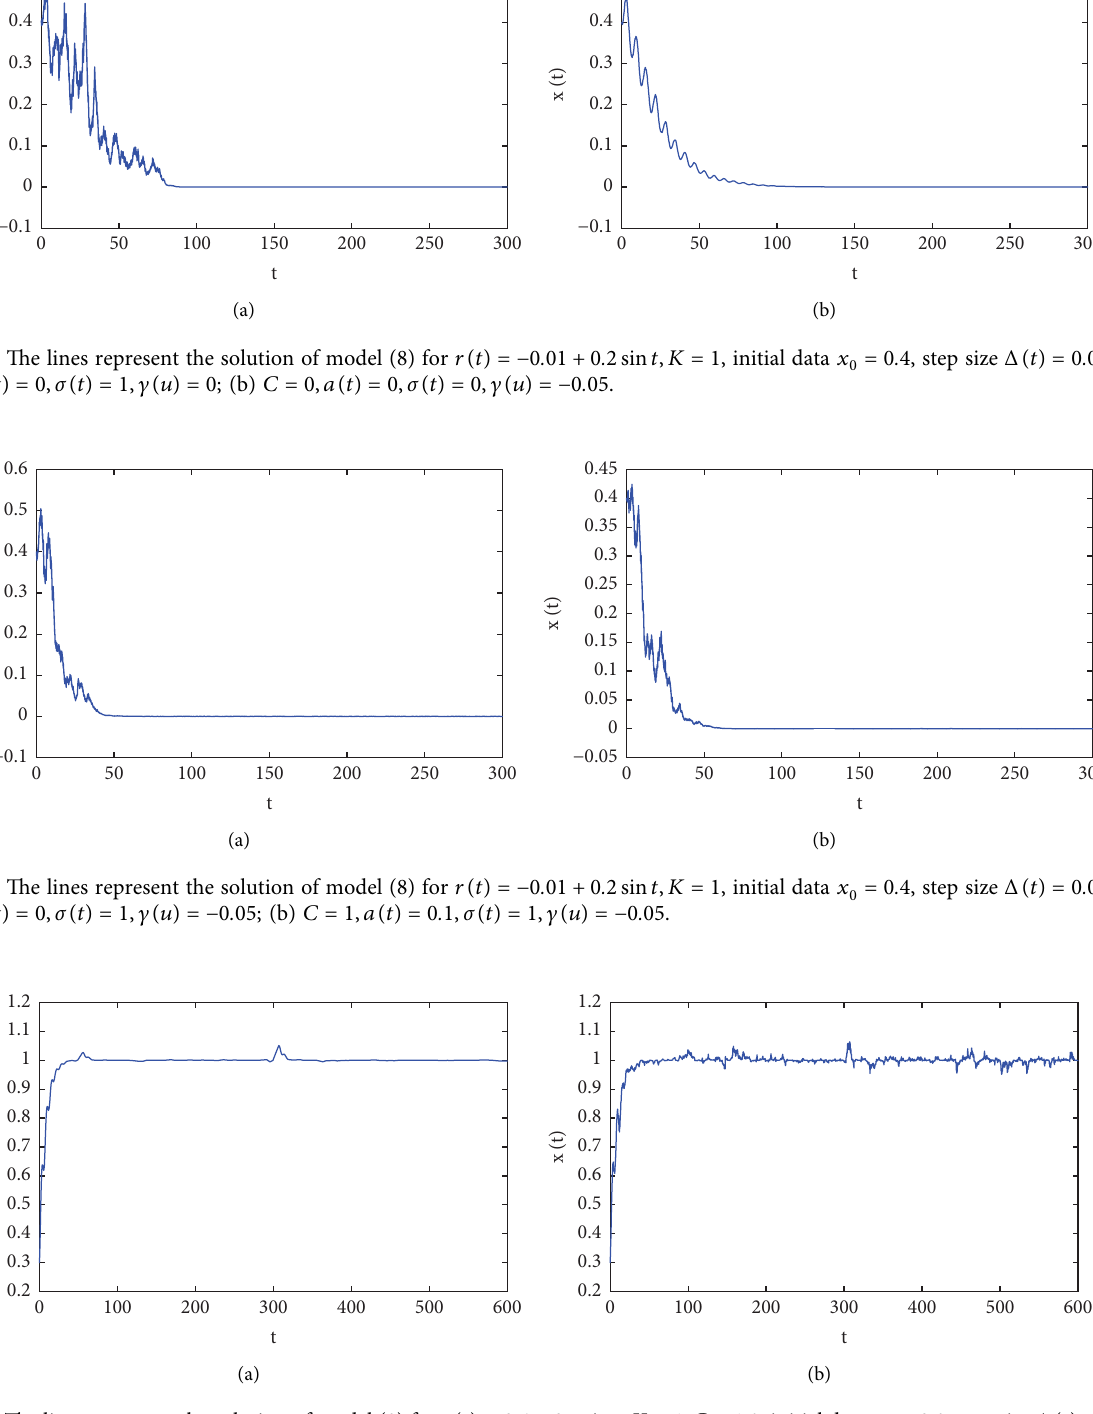
� 0 . 3, step size Δ ( t ) � 0 . 001. 0